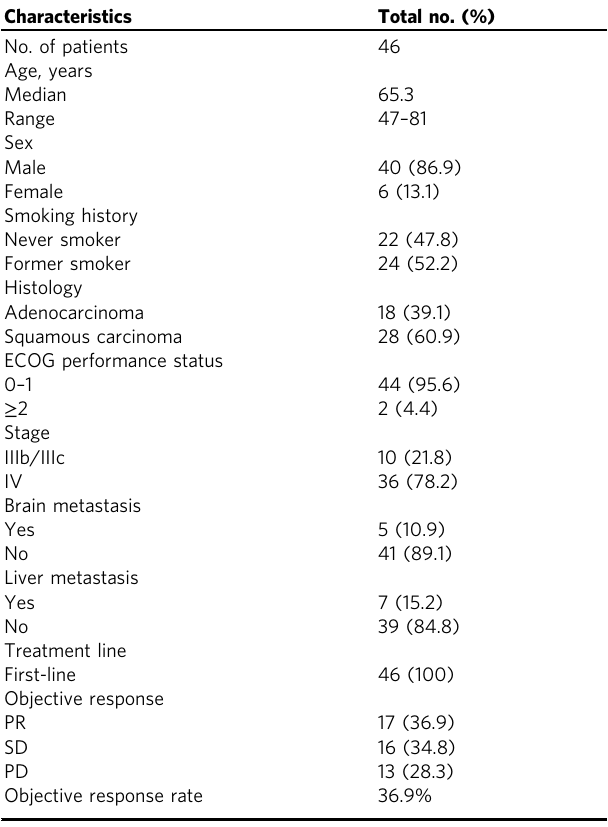
Table 1 Clinical characteristics of the 46 patients with NSCLC who received fi rst-line pembrolizumab treatment.